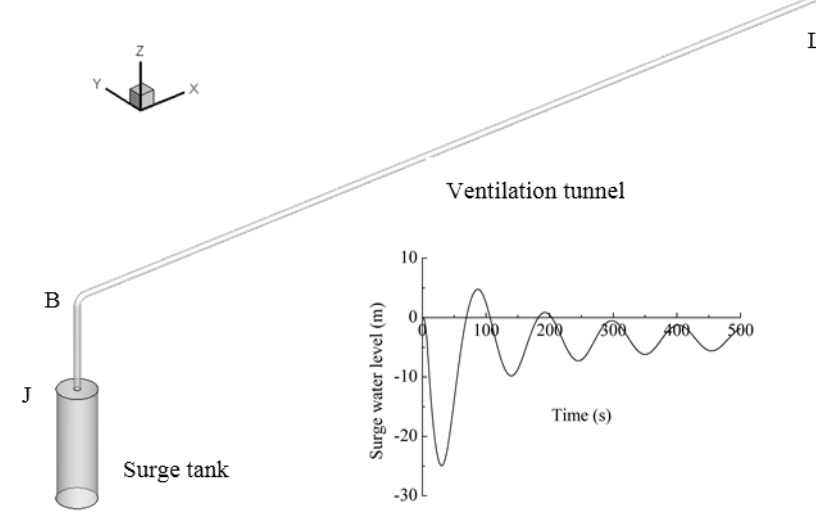
Figure 6. The layout for the “surge tank—ventilation tunnel” system and the water-level fluctuation process for the case of a surge tank (project case).